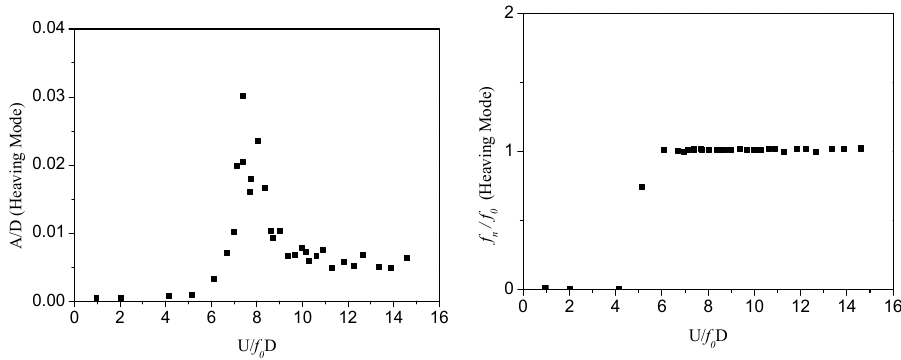
Figure 9. Heaving mode amplitude and frequency response of the 2D section model.